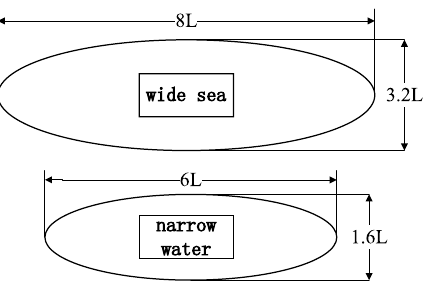
Fig. 6 FUJII ship domain model.The schematic diagram of the FUJII ship domain model proposed by Japanese ship expert FUJII in the